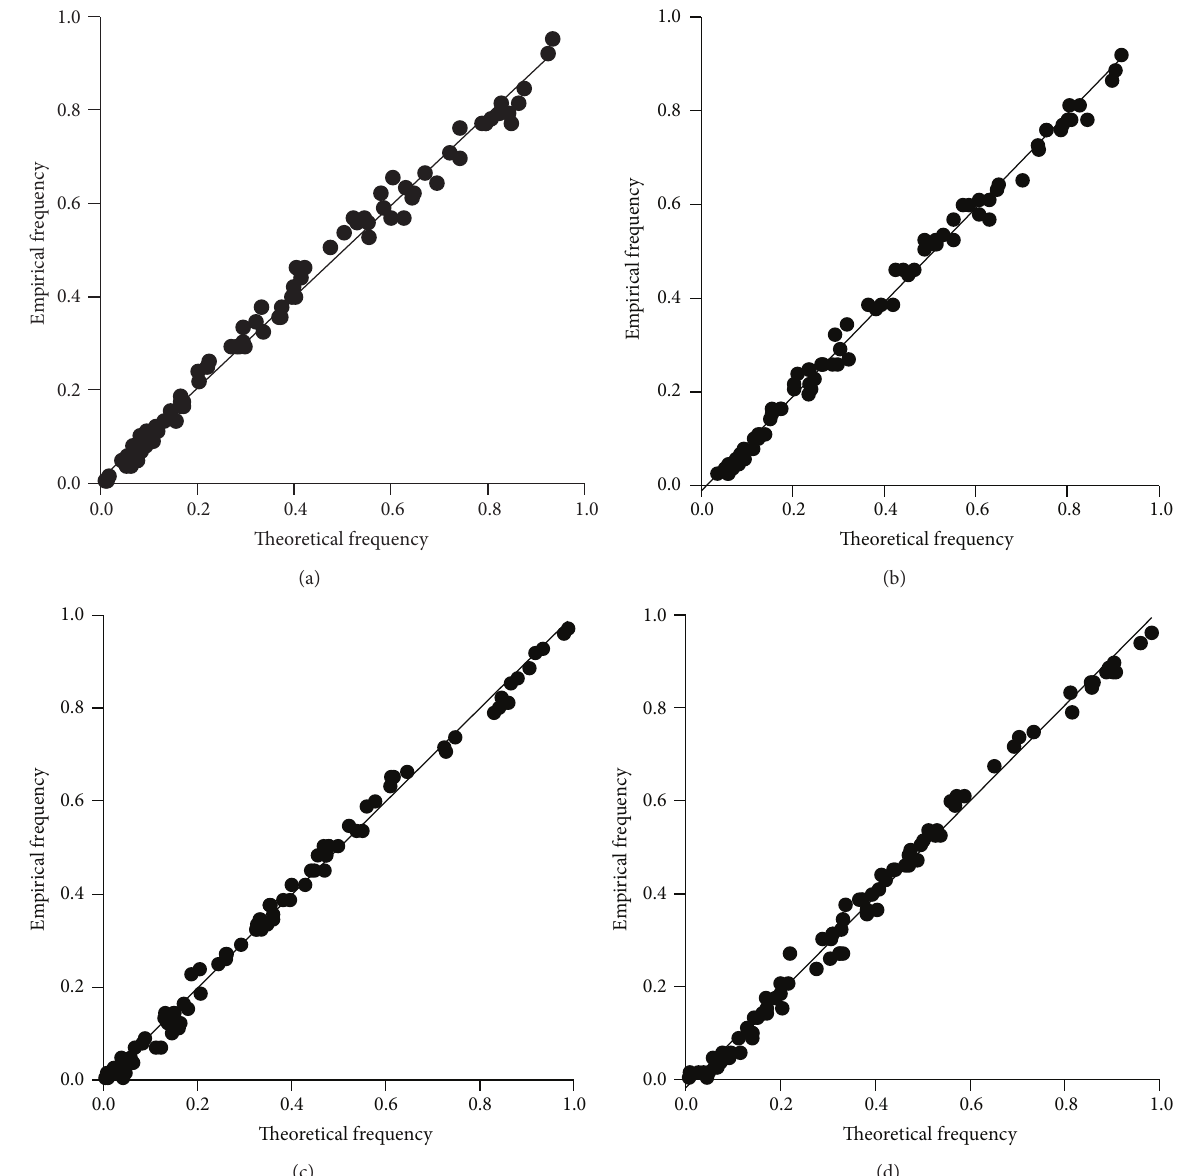
Figure 3: Empirical and theoretical frequency of 2D Gumbel Copula function joint distribution for different combination of the POT series: (a) RX1day-W1, (b) RX1day-W3, (c) RX3day-W1, and (d)